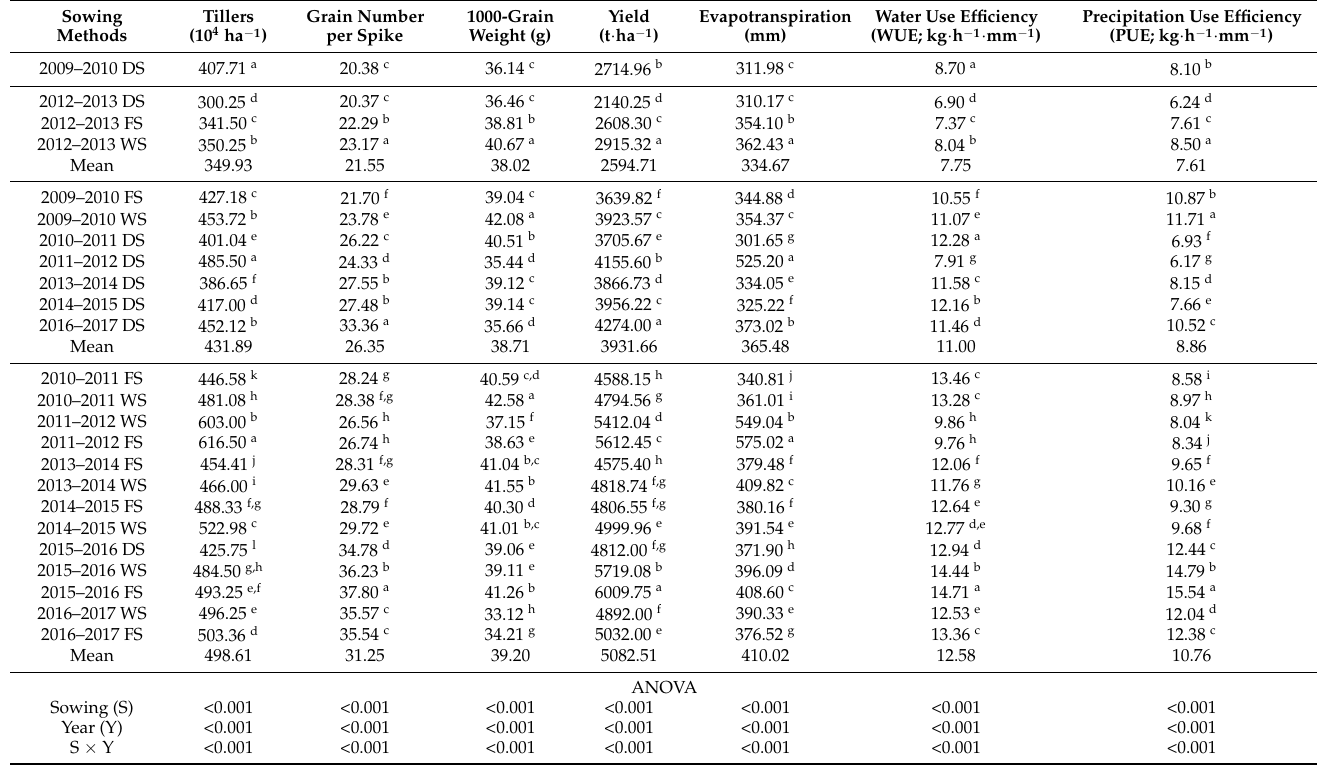
Table 2. Differences in yield components and WUE under DS, FS, and WS treatments.